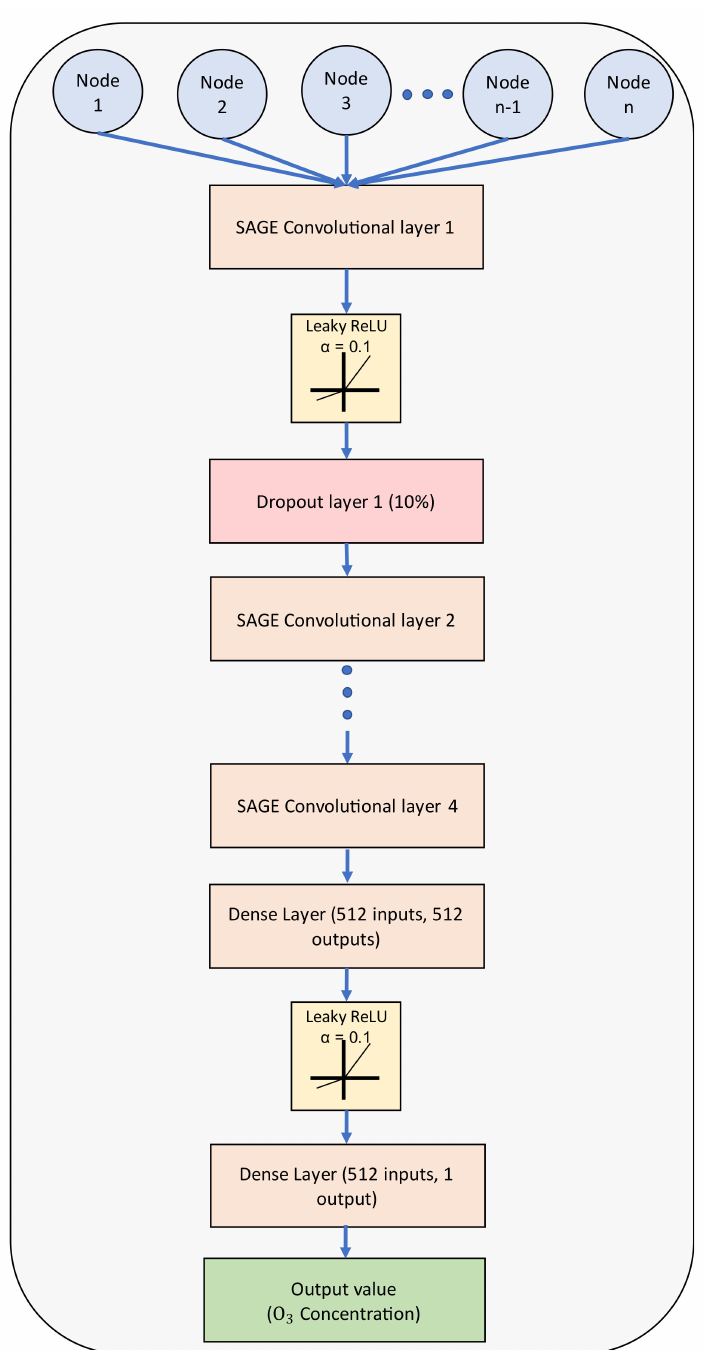
Figure 4. Proposed GraphSAGE structure